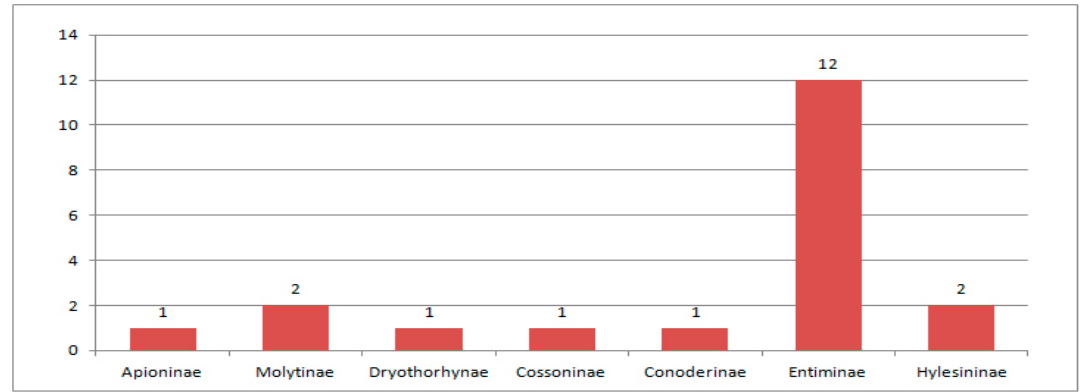
Figure 24. Composition of species of Curculionoidea in Aix-en-Provance.